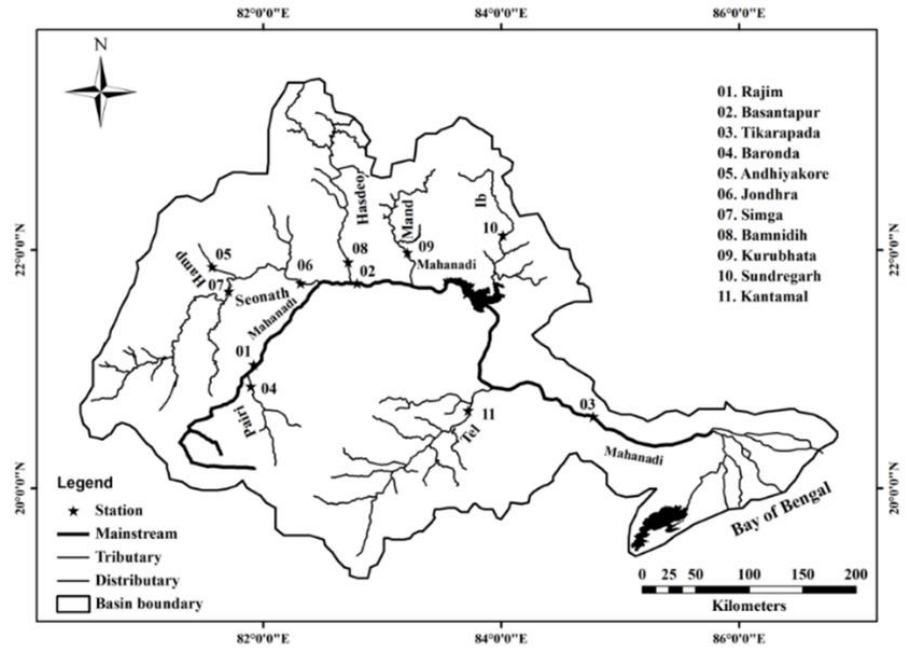
Figure 1. Location map of the Mahanadi basin with hydro-meteorological stations adapted from [28]. Based on daily data from 1971 to 2004, the mean annual RF ranged from 1200 to 1400 mm [39]. During the monsoon season (June to October months), the basin of Mahanadi receives approximately 90 percent of its annual RF. The RF distribution in the MR basin is uneven. According to daily data from 1969 to 2004, during the warmer months of April and May, the maximum T varies from 39 to 45 degrees Celsius, and during the winter months of December and January, minimum T ranges from 4 to 12 degrees Celsius [39]. The highest and lowest relative humidity variations are 68–87 percent and 9–45 percent,